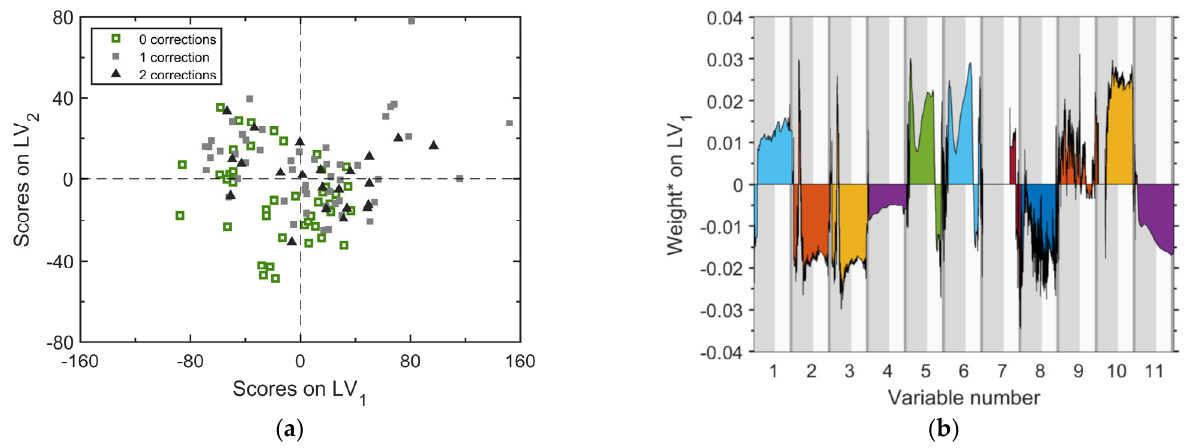
Figure 6. Two-component PLS-DA model for R202. ( a ) Scores plot (each marker represents a charge to R202, and the different shapes of the markers denote a different number of corrections eventually required); ( b ) time trajectories of the weights for the first latent variable for each process variable (the variable numbering is reported in the Appendix A). For each variable in ( b ), the first grey-shaded area represents the charging stage, the central white-shaded area is the decantation stage, and the last (very thin and barely visible) grey-shaded area is the transfer stage.